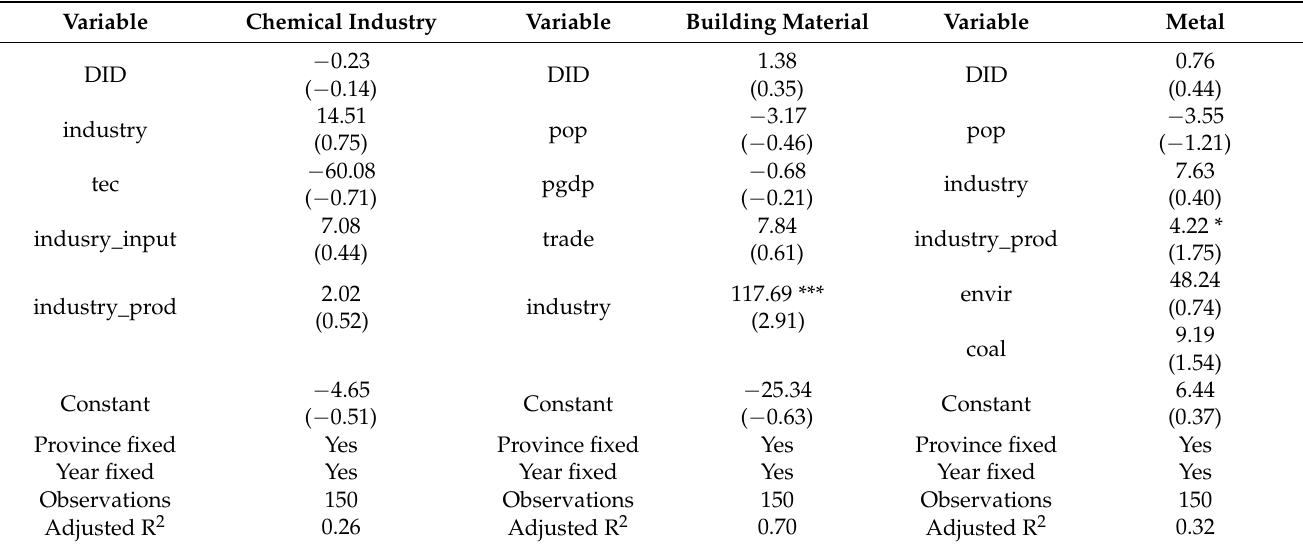
Table 4. Placebo test results of production-based carbon emissions reduction.